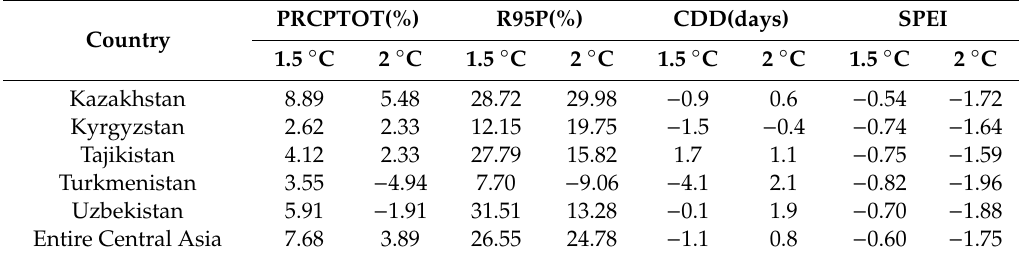
Figure 8. The spatial distribution of the consecutive dry days (CDD) in the reference period (1986–2005) ( a ) and the di ff erence ( b ) under 1.5 ◦ C and ( c ) 2 ◦ C global warming relative to reference period. Blue dots indicate that the decreasing trends are significant at the 1% level in these grids. Red dots indicate that the increasing trends are significant at the 1% level. Table 5. Changes in precipitation extreme indices under 1.5 and 2 ◦ C global